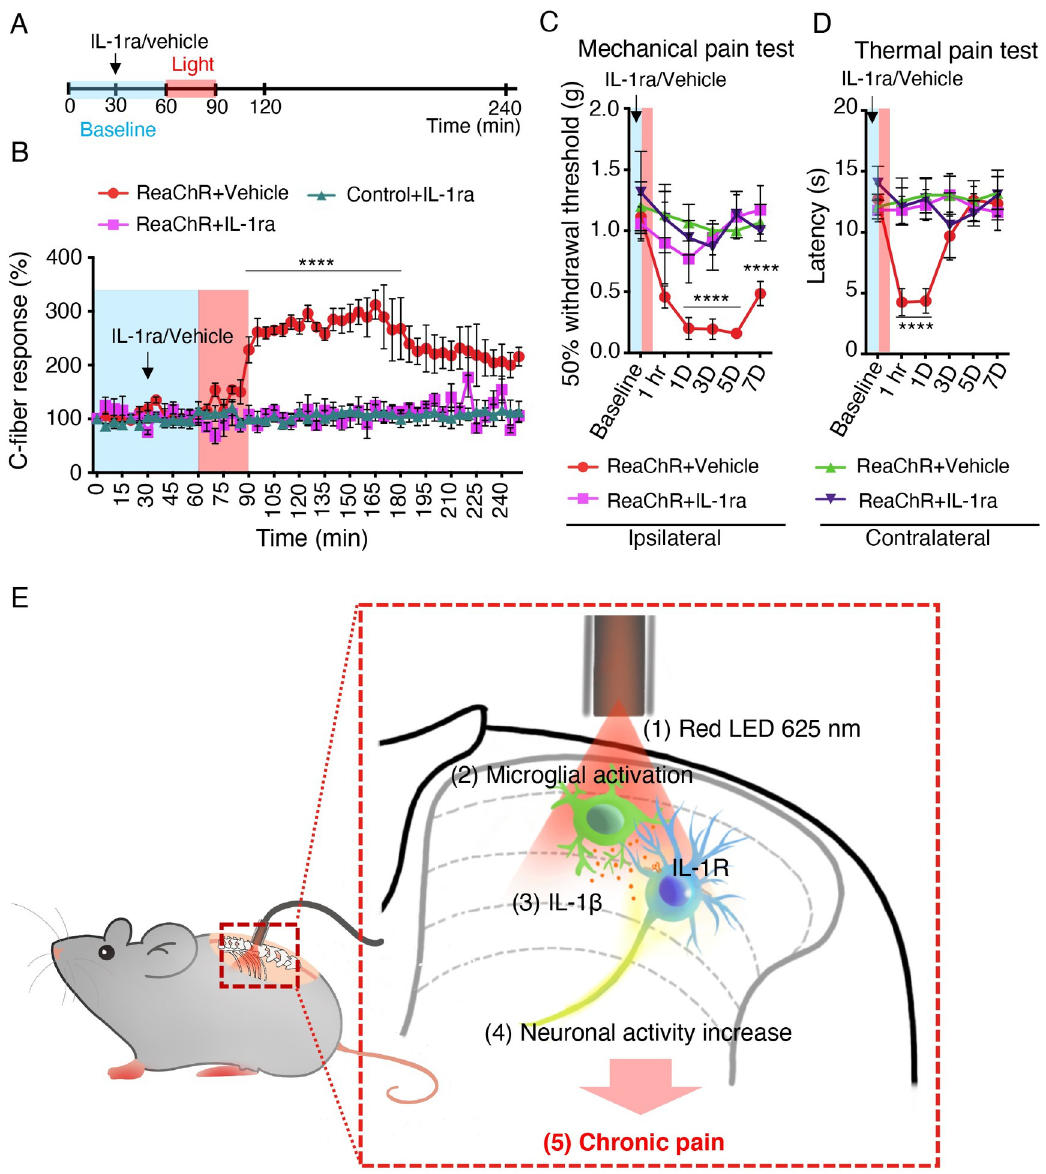
Fig 7. Inhibition of IL-1 β alleviates microglial ReaChR-induced pain hypersensitivity. (A) Timeline of experimental procedures for IL-1ra administration and light stimulation during in vivo recordings. (B) The time course of C-fiber–evoked field potentials before and after optogenetic stimulation of spinal microglia in each group (ReaChR+vehicle, ReaChR+IL-1ra, and control+IL-1ra). Vehicle and IL-1ra (10 μ L, 50 ng/mL) was topically administered after 30-min baseline recording and subsequently light stimulation was applied at 60 min. Black arrows and red bar indicate the time points of IL-1ra treatment and light stimulation, respectively (A, B). n = 4–5 mice/group. ���� P < 0.0001 vehicle vs. IL-1ra. Two-way ANOVA with multi- comparisons. (C, D) Light-induced mechanical (C) and thermal (D) pain hypersensitivity in ipsilateral or contralateral side of ReaChR mice after treatment of IL-1ra or vehicle. Data represented as mean ± SEM, n = 5–8 mice/group. ���� P < 0.0001 vehicle vs. IL-1ra. Two-way ANOVA with multi-comparisons. For data plotted in graphs, see S1 Data. (E) A schematic diagram illustrates that optogenetic stimulation of spinal microglia triggers chronic pain in ReaChR mice and highlights the possible mechanism involved. Red light stimulation (1) on the spinal dorsal horn induces microglial activation (2), which releases IL-1 β (3) and increases neuronal hyperactivity (4), leading to chronic pain hypersensitivity (5). IL, interleukin; IL-1ra, IL-1 receptor antagonist; ReaChR, red-activated